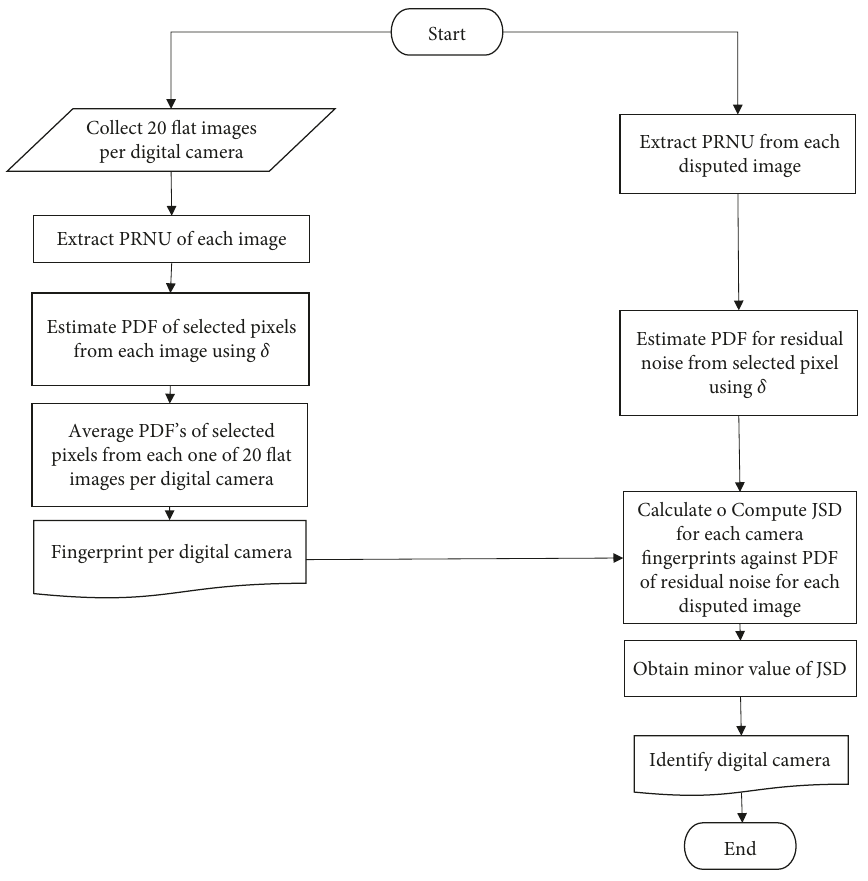
Figure 2: Flowchart of the proposed method assuming that δ allows select image